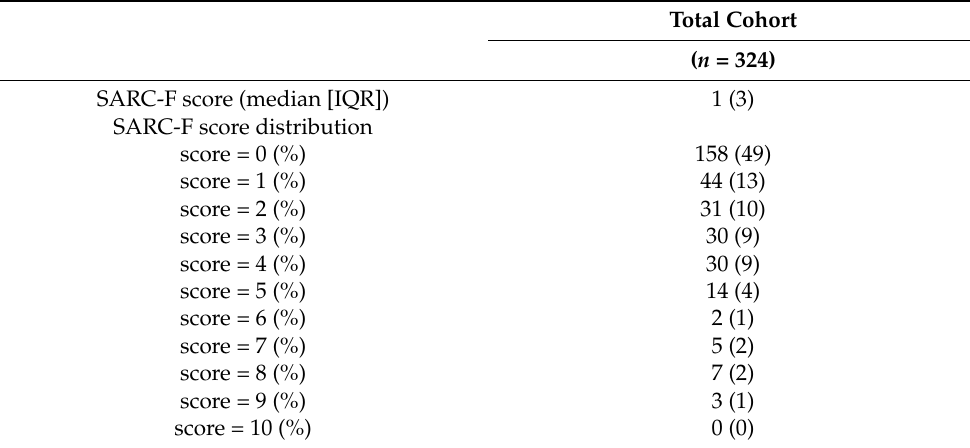
IQR = interquartile range.